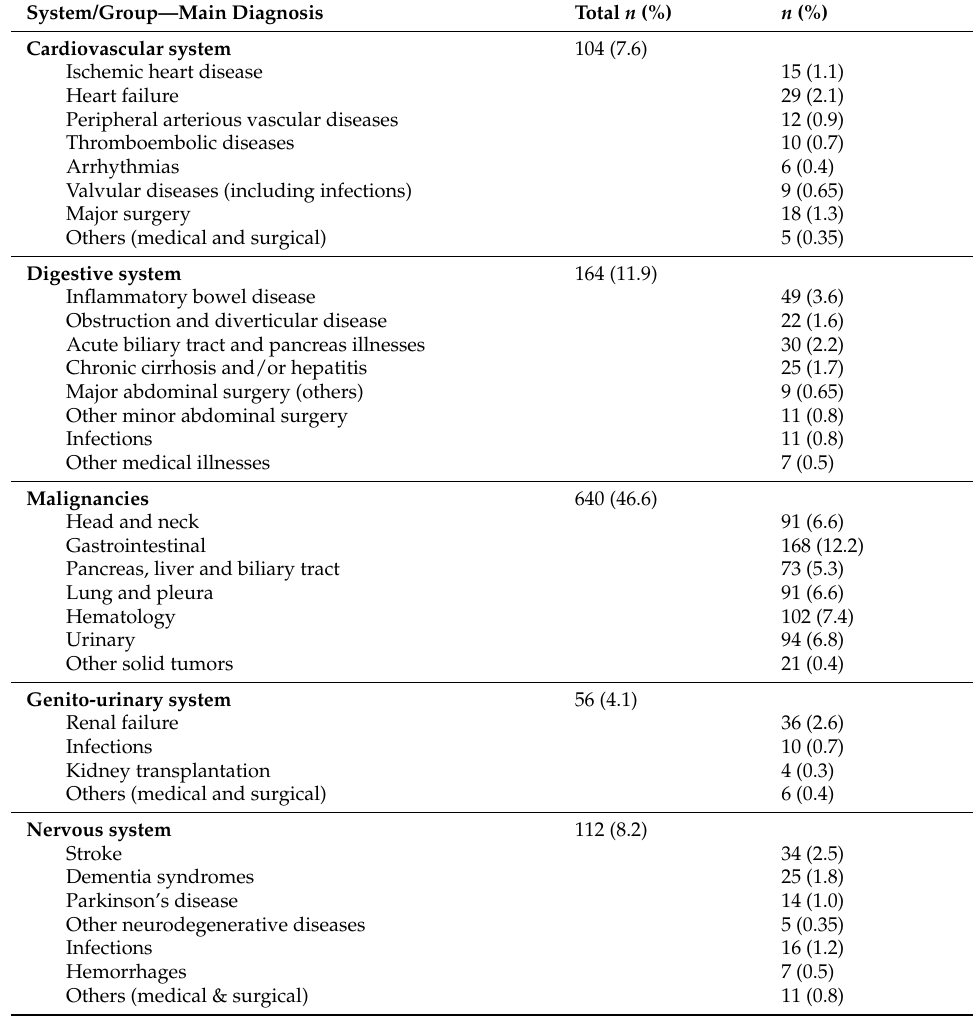
Table 2. Study population ( n = 1373): Distribution by main admission diagnoses. System/Group—Main